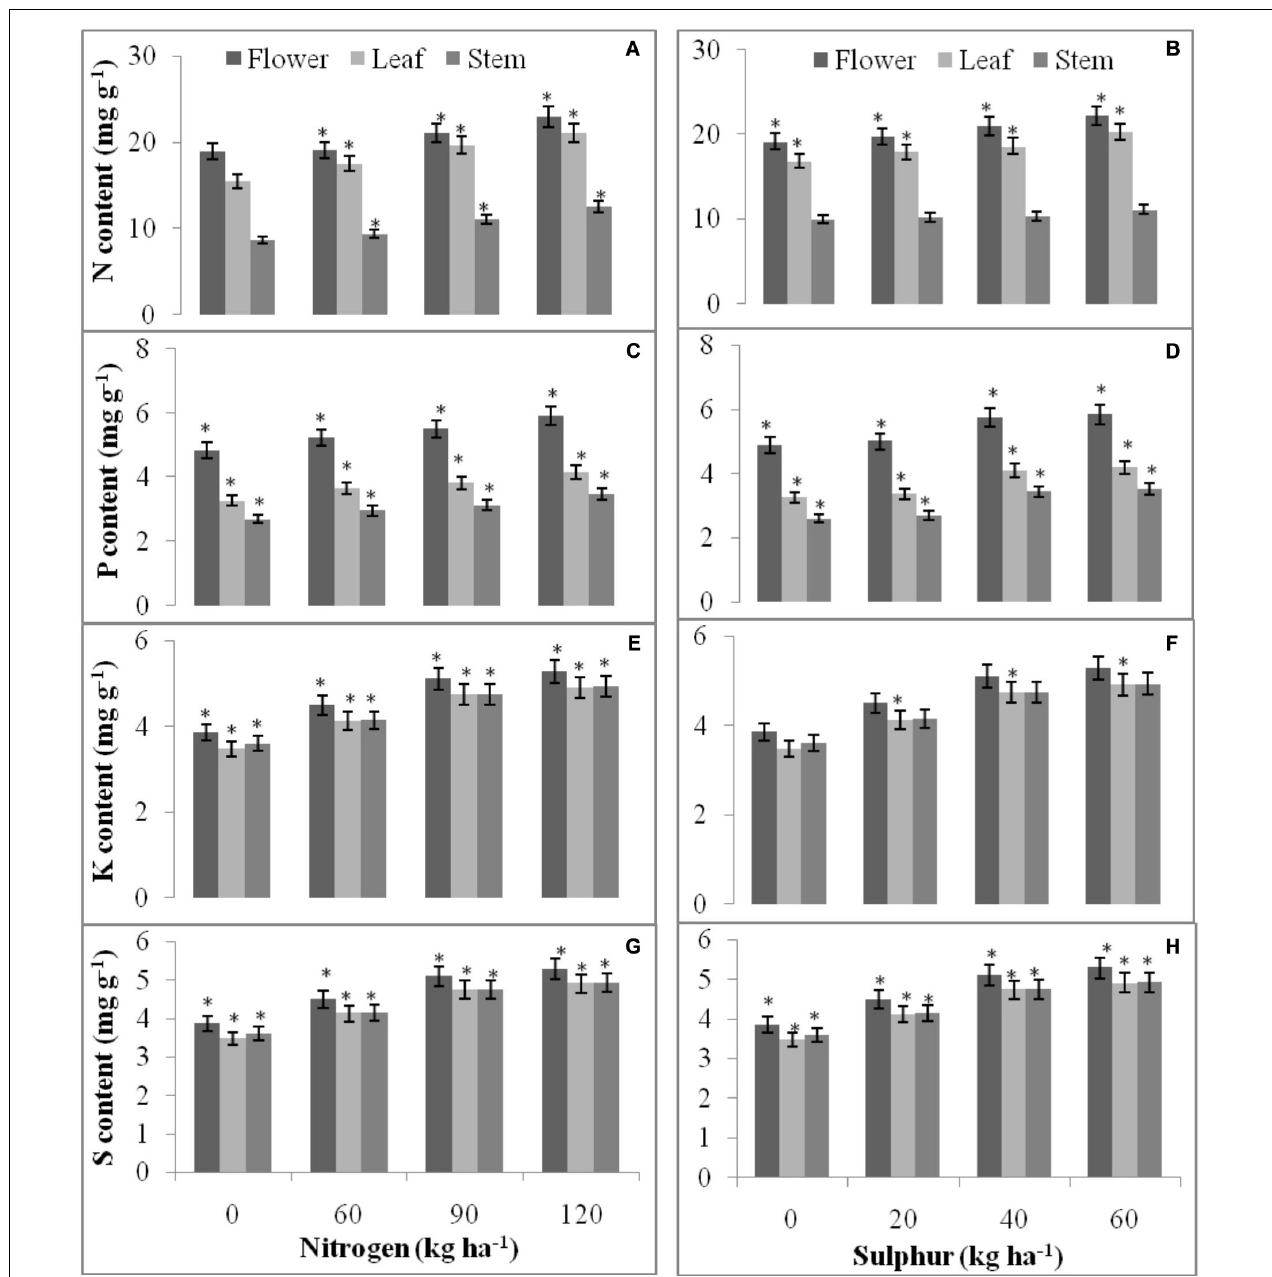
FIGURE 7 | Spatial and temporal accumulation of N (A,B) , P (C,D) , K (E,F) , and S (G,H) in T. minuta flower, leaf, and stem as influenced by applied N and S fertilizers. The mean values of 2 years pooled data are presented. Within each bar, the asterisk (*) indicates significant differences among fertilizer levels at P = 0.05. Vertical bars indicate a mean standard error ( ±